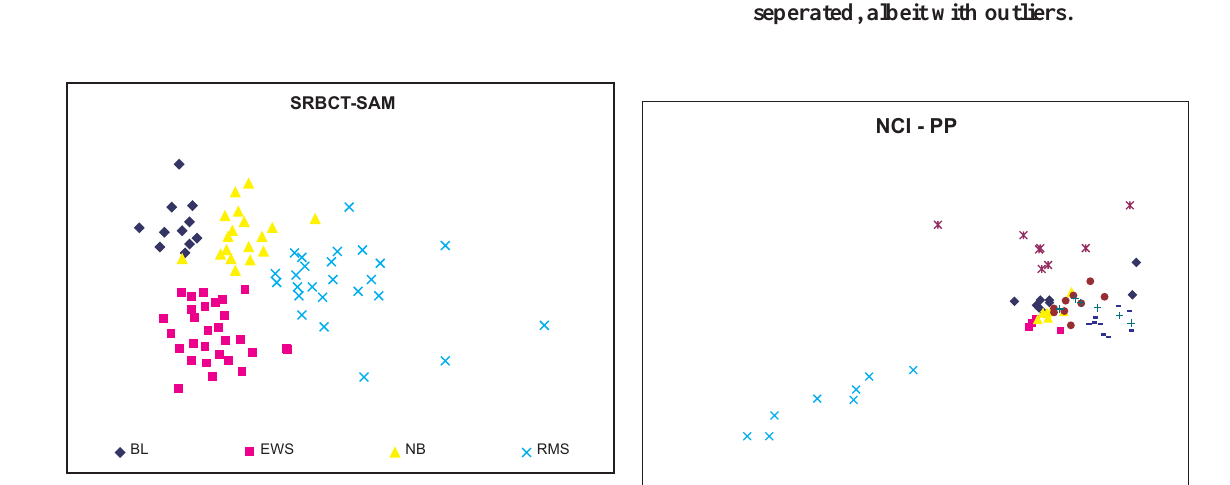
Figure 5.3: Two-Dimensional View of SRBCT data set produced by SAM method showing one aspect of the ‘curse of dimensionality’: the small variance between points in high dimensional space produces a reduced view with little ‘bunching’.